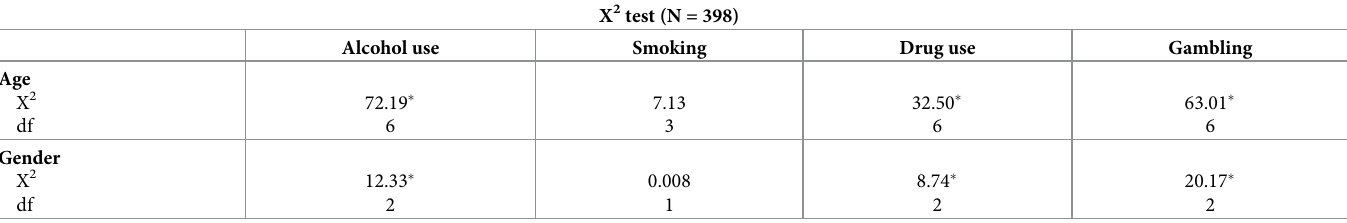
Table 5. Associations between students’ sociodemographic characteristics, substance use and